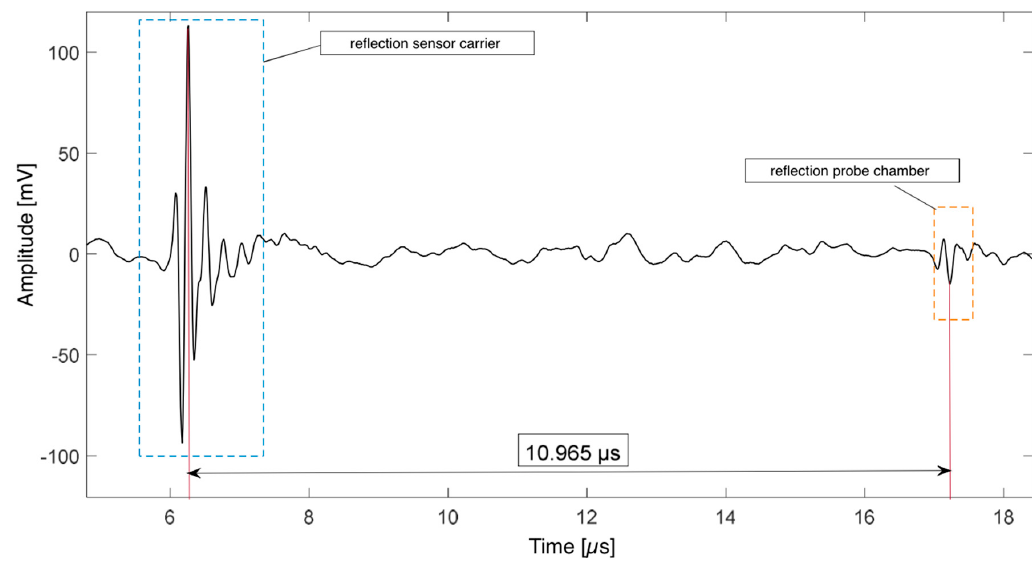
Figure 2. Reflected ultrasonic pulse signals at the boundary sensor carrier/probe and probe/probe